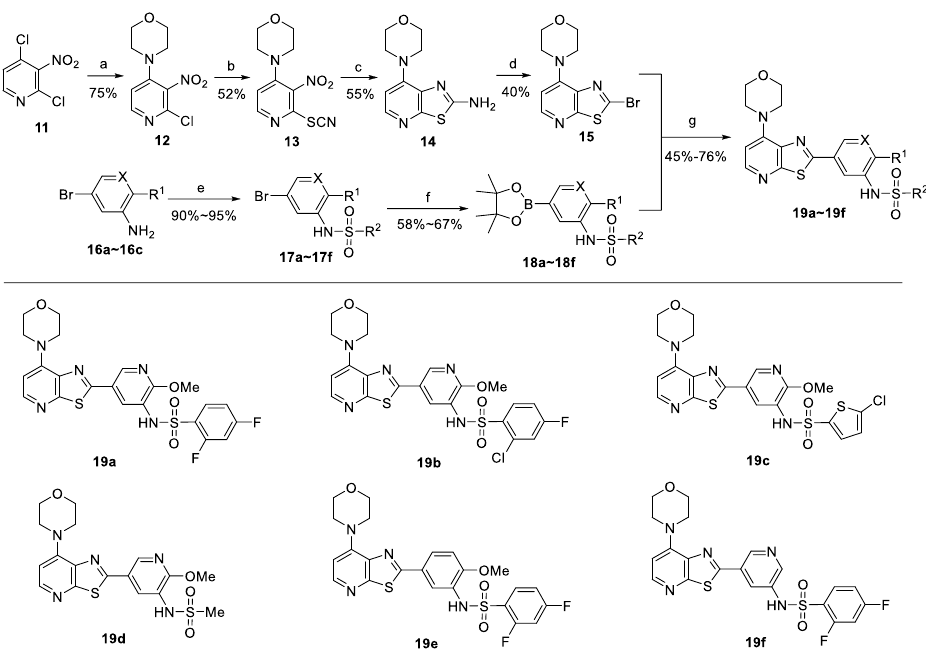
Figure 3. Synthesis of thiazolo[5,4- b ]pyridine analogues. ( a ) Morpholine, TEA, THF, 0 °C. ( b ) KSCN, HOAc, 80 °C. ( c ) Fe powder, HOAc, 60 °C. ( d ) CuBr 2 , tert-butyl nitrite, CH 3 CN, rt. ( e ) DMAP, pyridine, DCM, rt. ( f ) PdCl 2 (dppf), KOAc, bis(pinacolato)diboron, 1,4-dioxane, 100 °C. ( g ) PdCl 2 (dppf), K 2 CO 3 , 1,4-dioxane / H 2 O, aryl borate, 100 ◦ C. dppf = 1,1 ′ -Bis(diphenylphosphino)ferrocene. Table 1. SAR studies of 2-substitutions on the thiazolo[5,4- b ]pyridine. Compd X